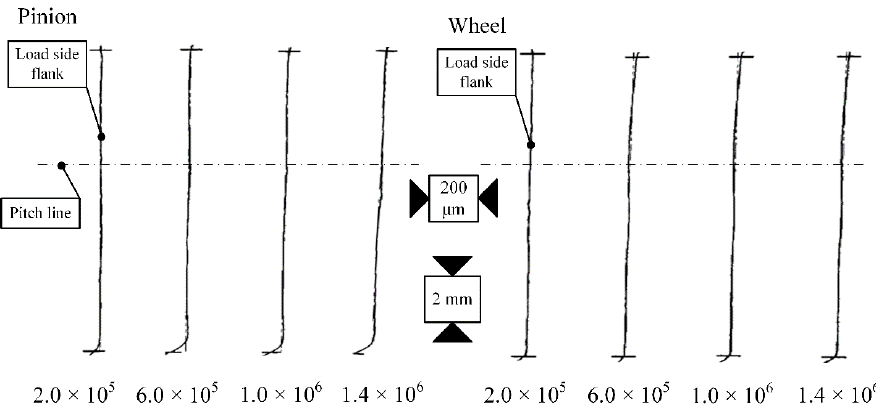
Fig. 17 Tooth profile deviations for the lubricated 20 N·m loading